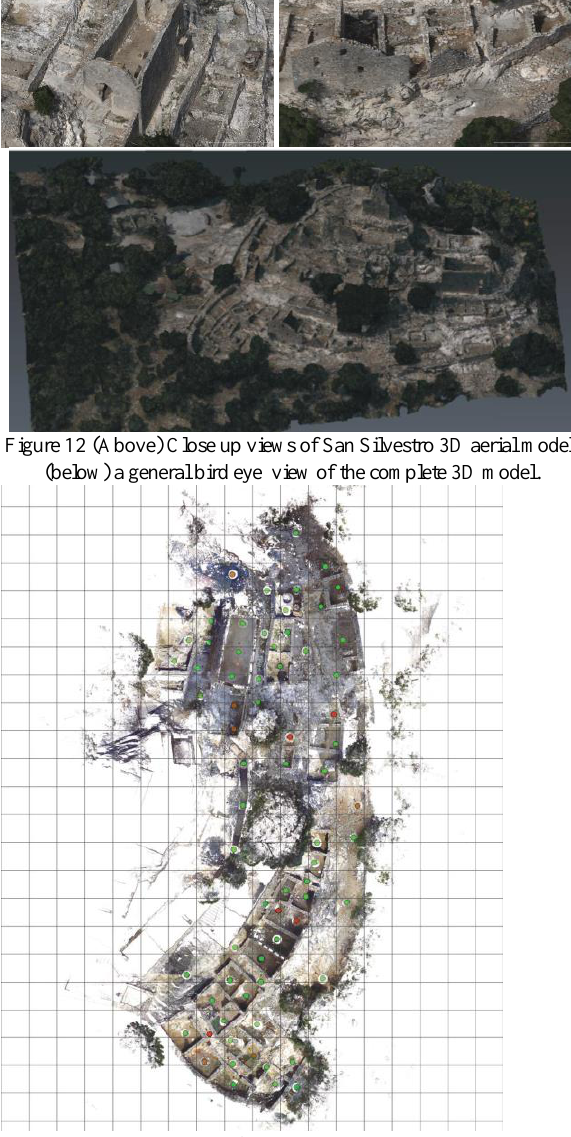
Figure 13. Plan view of the registered scans pertaining the residential district of the Rocca di San Silvestro (PointCab software) (Villa,